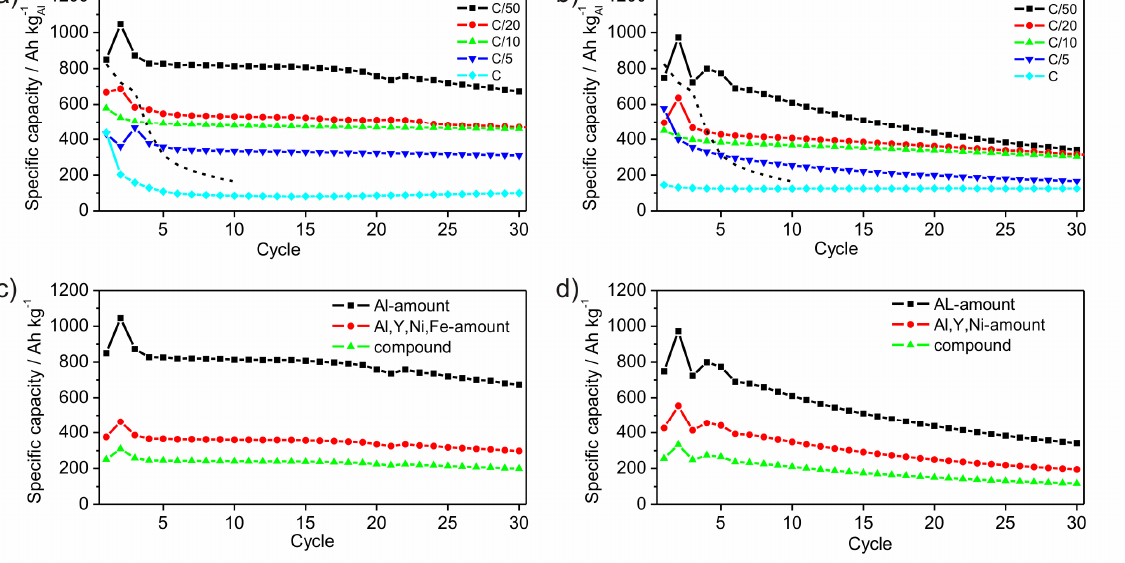
Li Ni Y 43 43 8 6